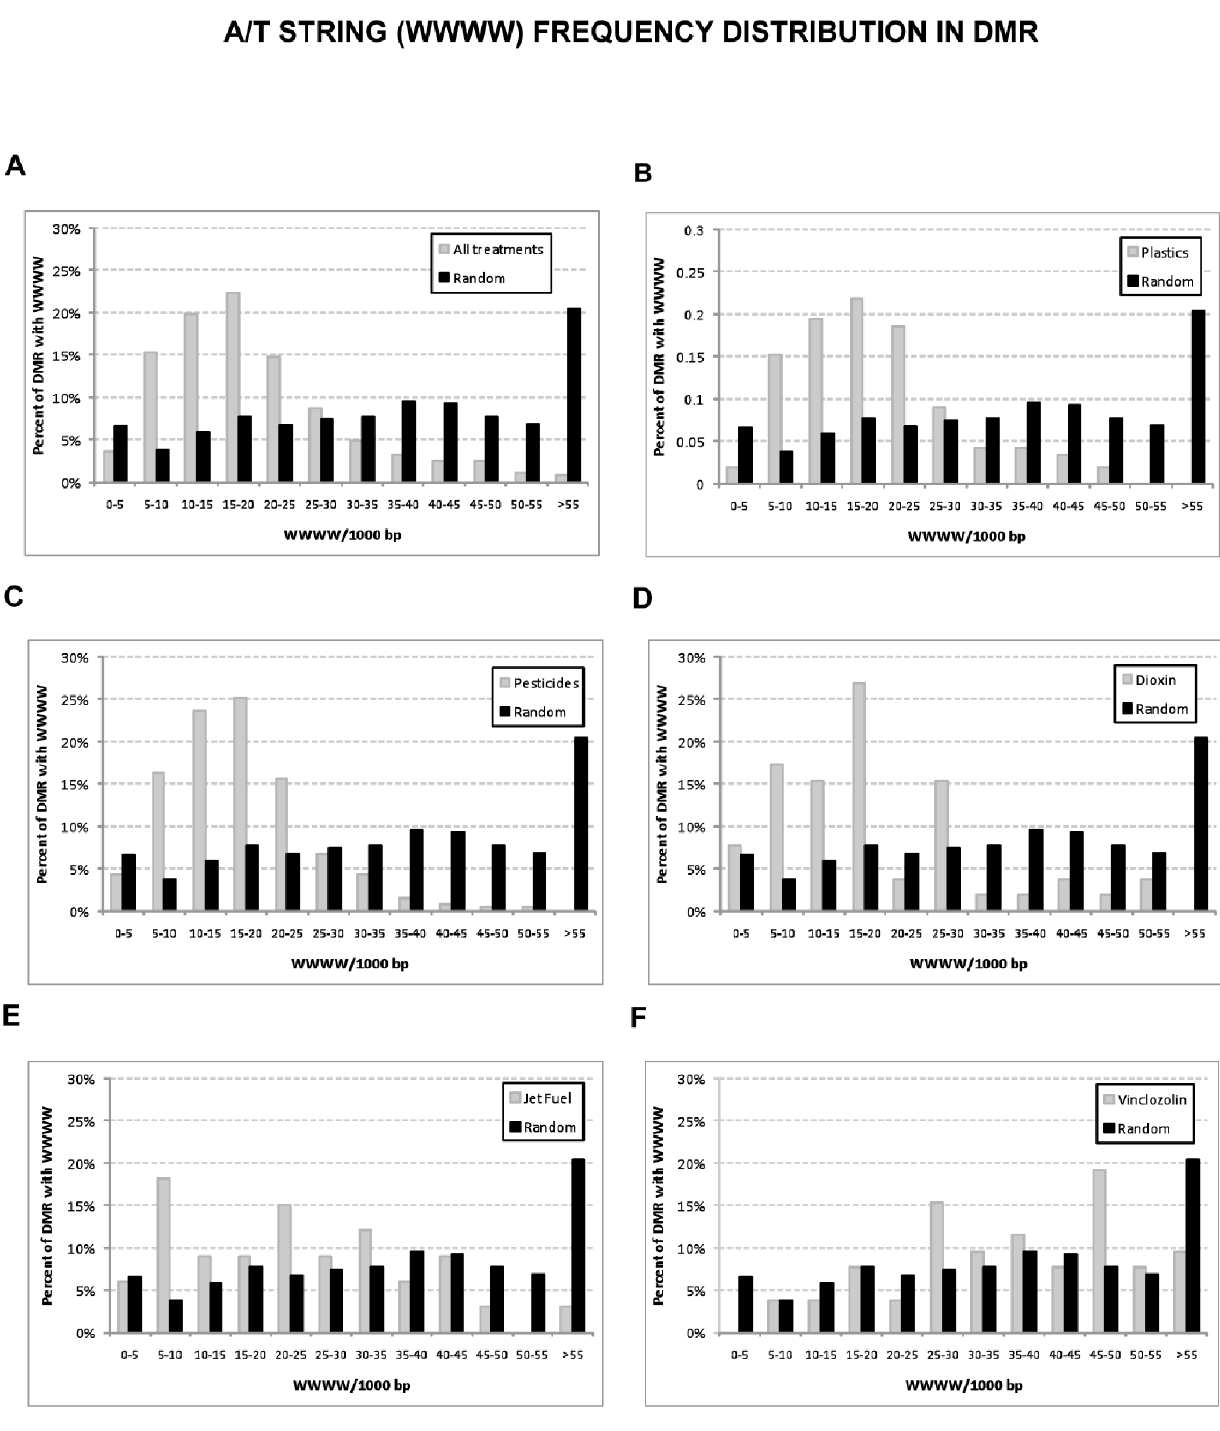
Figure 6. Distribution of A/T string (WWWW) incidence across the transgenerational DMR sets. The percent of DMR with A/T string sequences for all DMR (A), plastics (B), pesticides (C), dioxin (D), jet fuel (E), and vinclozolin (F) are presented compared to the random sequence data set. doi:10.1371/journal.pone.0100194.g006 tially bind to methylated DNA [53]. The potential that zinc finger binding regions may be targets for DNA methylation changes that will maintain DNA methylation alterations transgenerationally needs to be further investigated. DNA methylation changes in zinc finger rich regions may also preferentially occur in the germline.